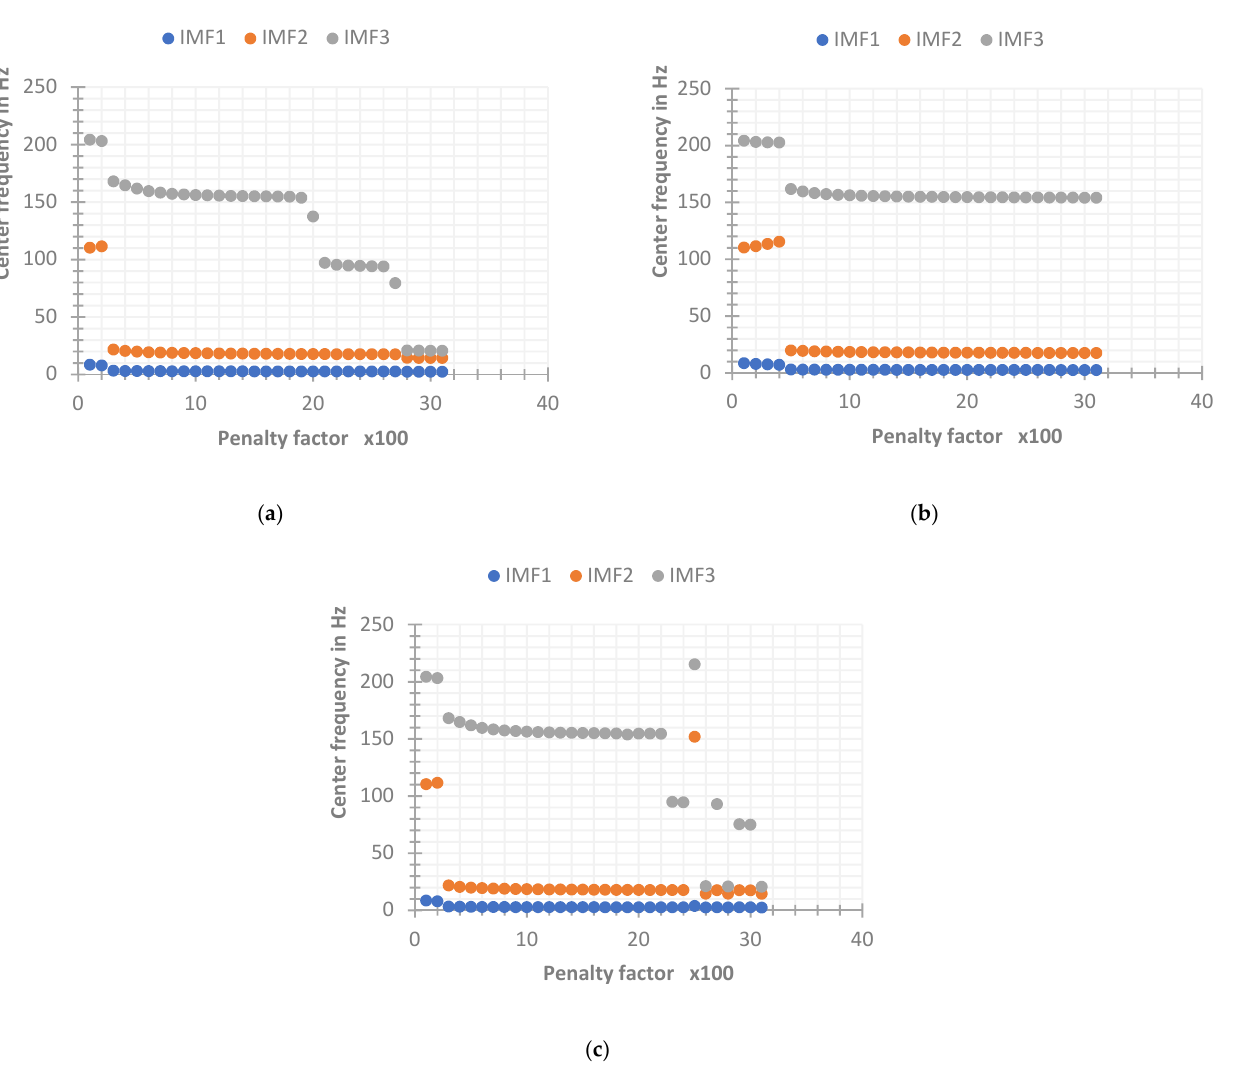
Figure 10. Convergence frequency of different initial center frequency setting methods under − 6 dB.